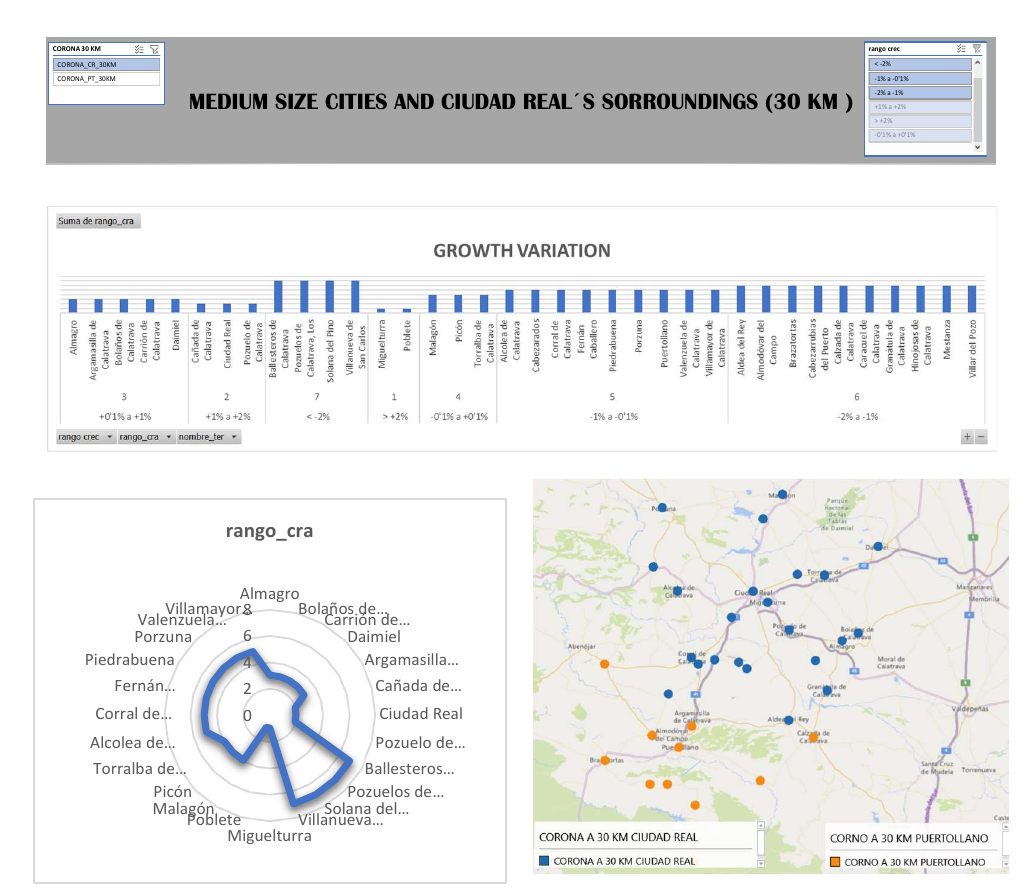
Figure 3. Growth Variation range in medium size cities of Ciudad Real province, Source: Compilation based on D2CR project. * This information under graphic Growth variation.